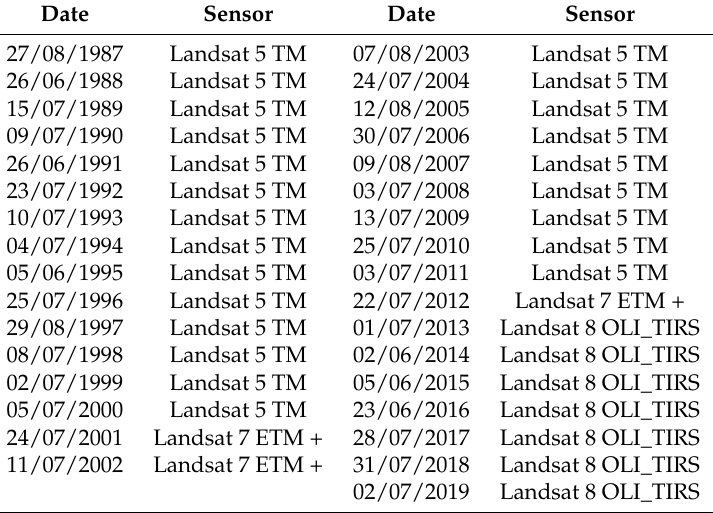
Table 1. Temporal distribution of available Landsat images in Longgan Lake during 1987 to